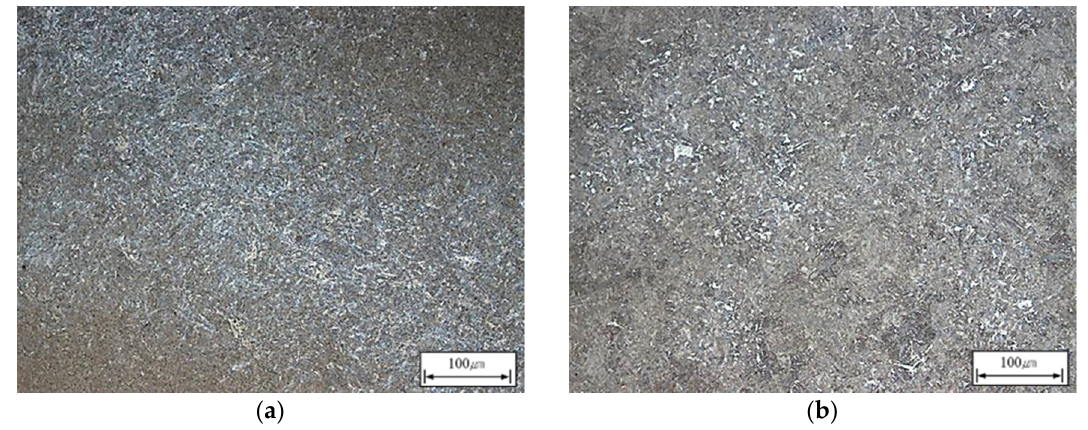
Figure 12. Test specimen extraction positions.